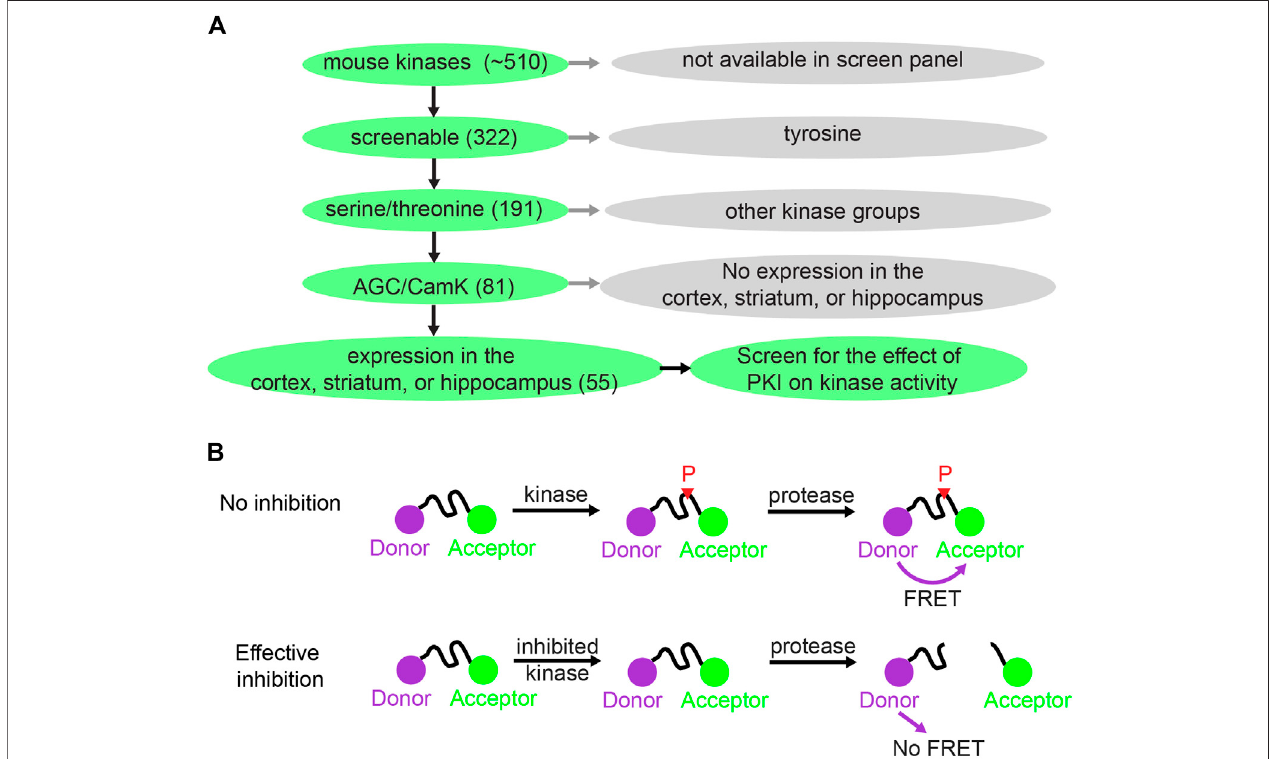
FIGURE 1 | Kinase selection and screening strategy for the effect of PKI on kinases. (A) Schematic showing how 55 kinases were selected out of ∼ 510 mouse kinasesforscreeningoftheeffectofPKIonkinaseactivity. (B) SchematicillustratingtheprincipleoftheZ ′ -LYTEKinaseAssayfromThermoFisher(Rodemsetal.,2002). With no inhibition, the kinase phosphorylates the kinase substrate that separates between the donor (coumarin) and acceptor ( fl uorescein). The phosphorylation prevents subsequent cleavage by a site-speci fi c protease. Thus, the uncleaved phosphorylated product will exhibit F Ö rster Resonance Energy Transfer (FRET). With effective kinase inhibition, the peptide is not phosphorylated and is subsequently cleaved by the protease, and hence there is no FRET.